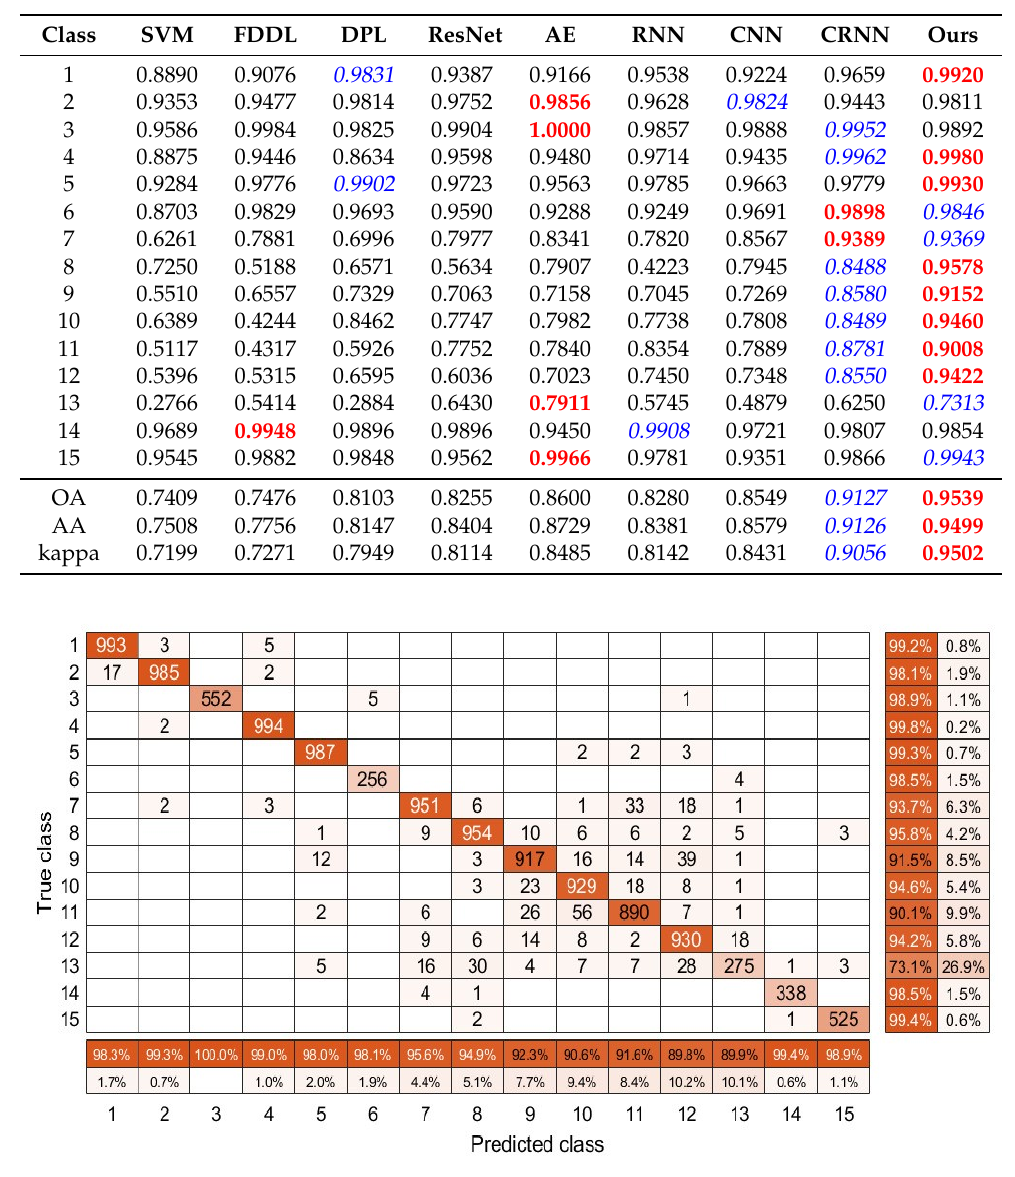
Table 3. Classification Accuracy for Houston 2013 Dataset. The red bold fonts and blue italic fonts indicate the best and the second best performance.